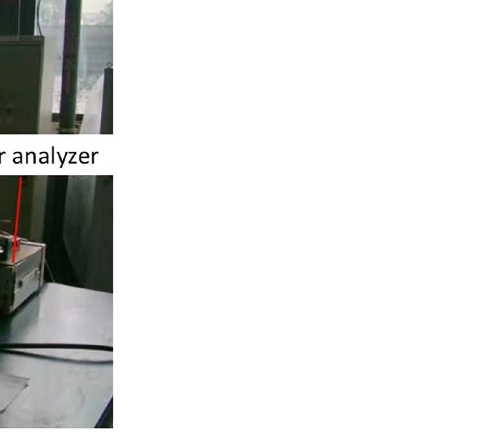
Figure 5. Prototype